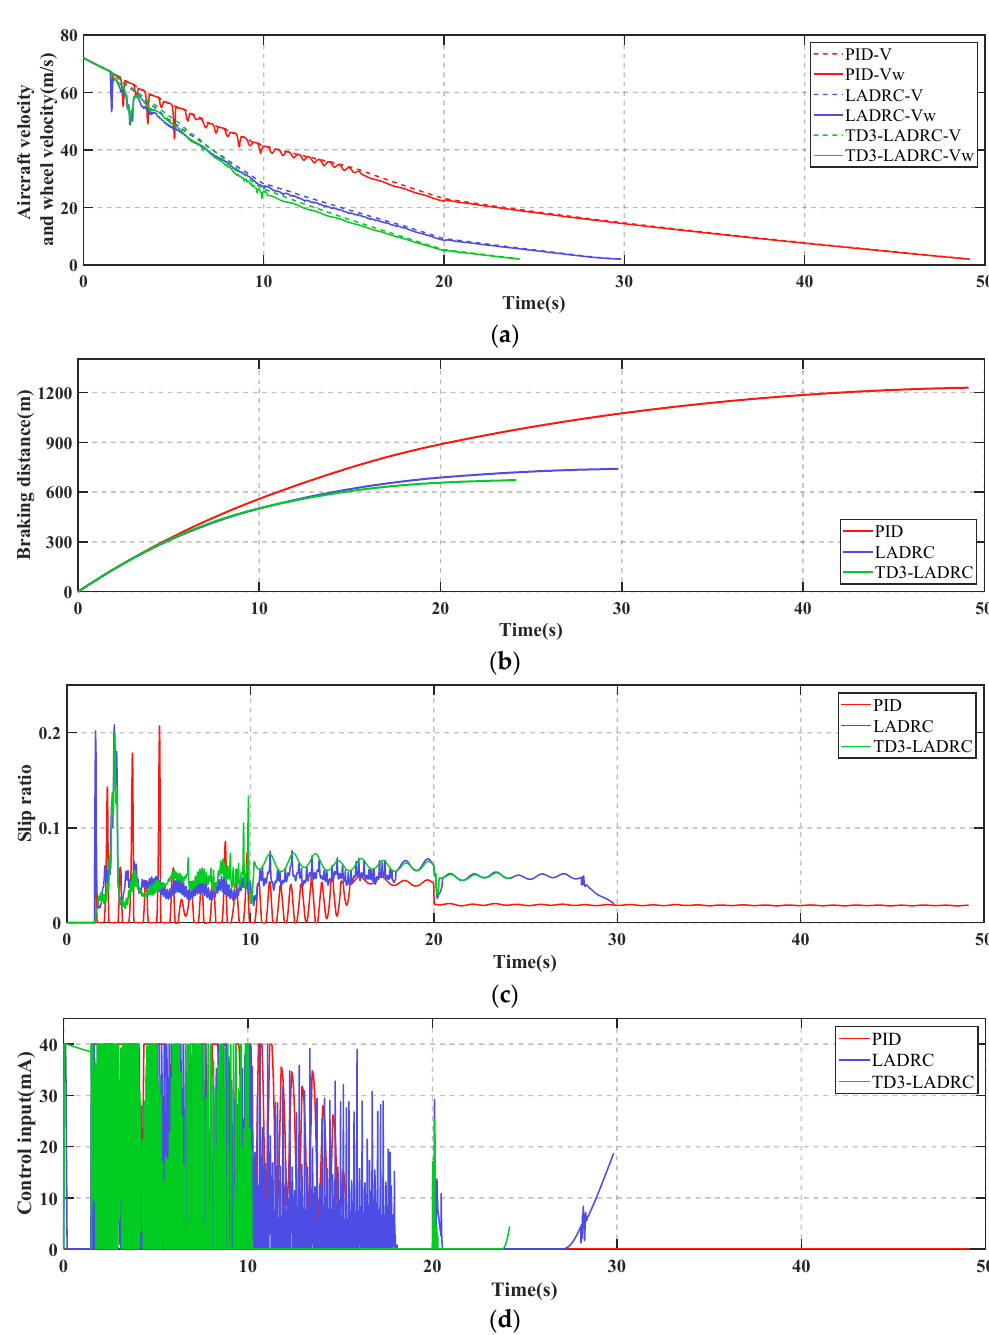
Figure 11. ( a ) Aircraft velocity and wheel velocity; ( b ) breaking distance; ( c ) slip ratio; ( d ) control input.